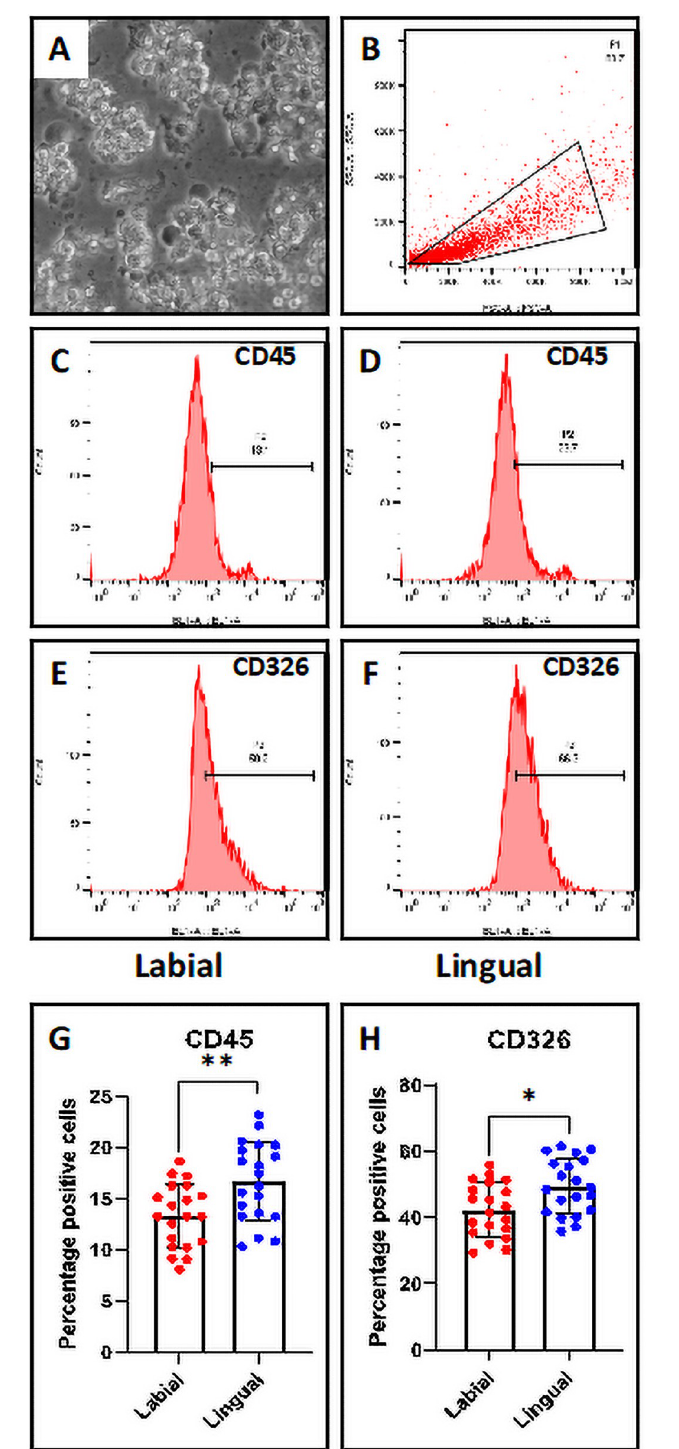
Fig 2. Flow cytometry-based analysis of salivary cells. (A) Salivary cells. Scale bar = 100 μ m (B) Gated population of salivary cells. (C & D) CD45 marker analysis of salivary cells from labial and lingual subjects. (E & F) CD326 marker analysis of salivary cells from labial and lingual subjects. (G) Comparative analysis of percentage of CD45+ cells in the saliva from labial and lingual subjects. (H) Comparative analysis of percentage of CD45+ cells in the saliva from labial and lingual subjects. n.s. not significant, � p < 0.05, �� p < 0.001. CD45: Protein tyrosine phosphatase, receptor type, C, CD326: Epithelial cell adhesion molecule.